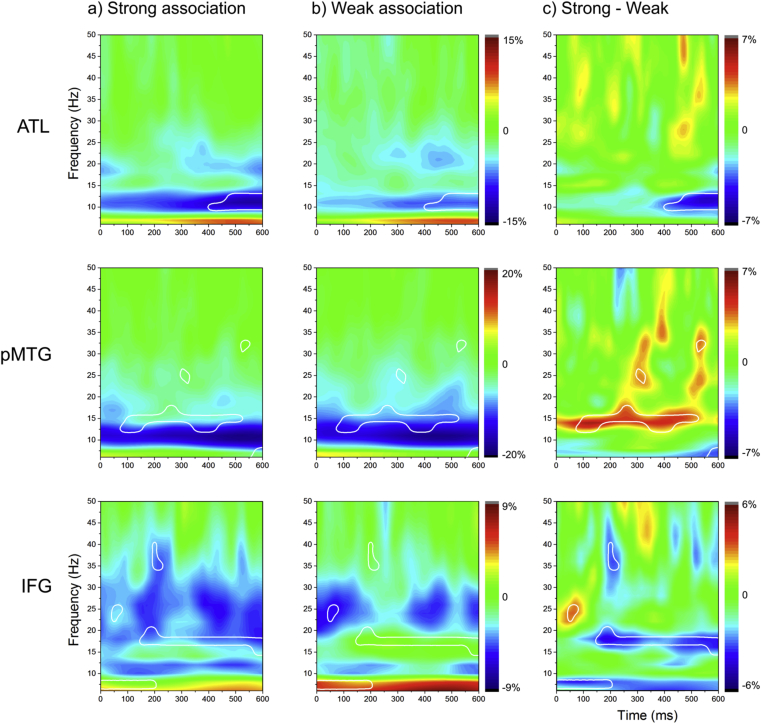
a) Percentage signal change in the strong condition, relative to baseline. b) Percentage signal change in the weak condition, relative to baseline. c) Percentage signal change between strong and weak conditions, separately for ATL, pMTG and IFG. White lines are derived from the statistical comparison between strong and weak conditions. The boundaries enclose regions fulfilling two criteria: i) percentage signal change between the strong and weak conditions is significantly different from zero (p < .05) and ii) percentage signal change computed separately for each condition is significantly different from zero for at least one of the two conditions. Yellow–red colours indicate regions of power increase relative to the baseline, while cyan–blue indicates power decreases relative to the baseline, and green indicates no change from baseline.